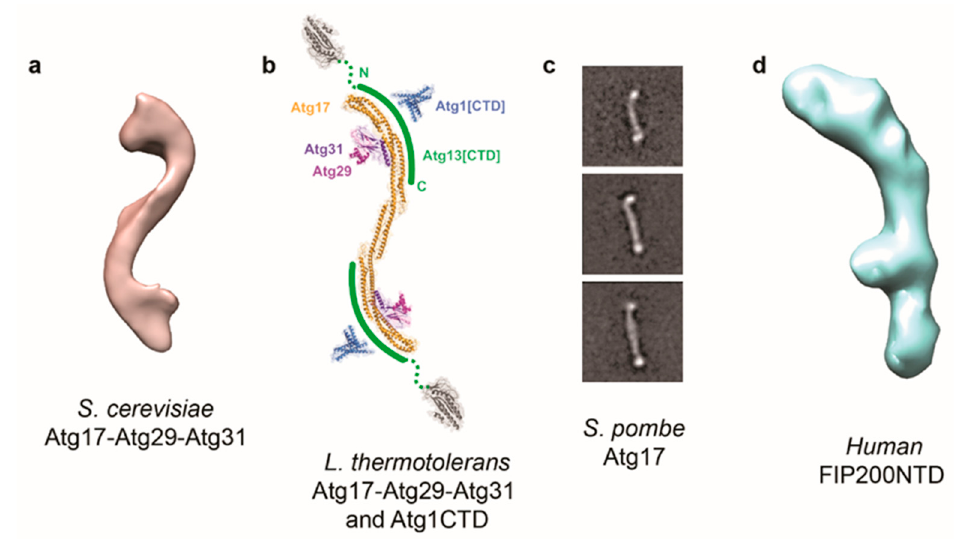
Figure 1. 3D electron microscopy (EM) reconstructions and subunit arrangement of Atg1 complex and FIP200. ( a ) Negative stain EM reconstruction of Saccharomyces cerevisiae Atg17-Atg29-Atg31. ( b ) Proposed subunit arrangement of Lachancea thermotolerans Atg1 complex based on results from negative stain electron microscopy, X-ray crystallography, and cross-linking coupled to mass-spectrometry. ( c ) Representative 2D class averages of Schizosaccharomyces pombe Atg17 from negative stain EM. ( d ) 3D cryo-EM reconstruction of human FIP200NTD (EMD-21325).